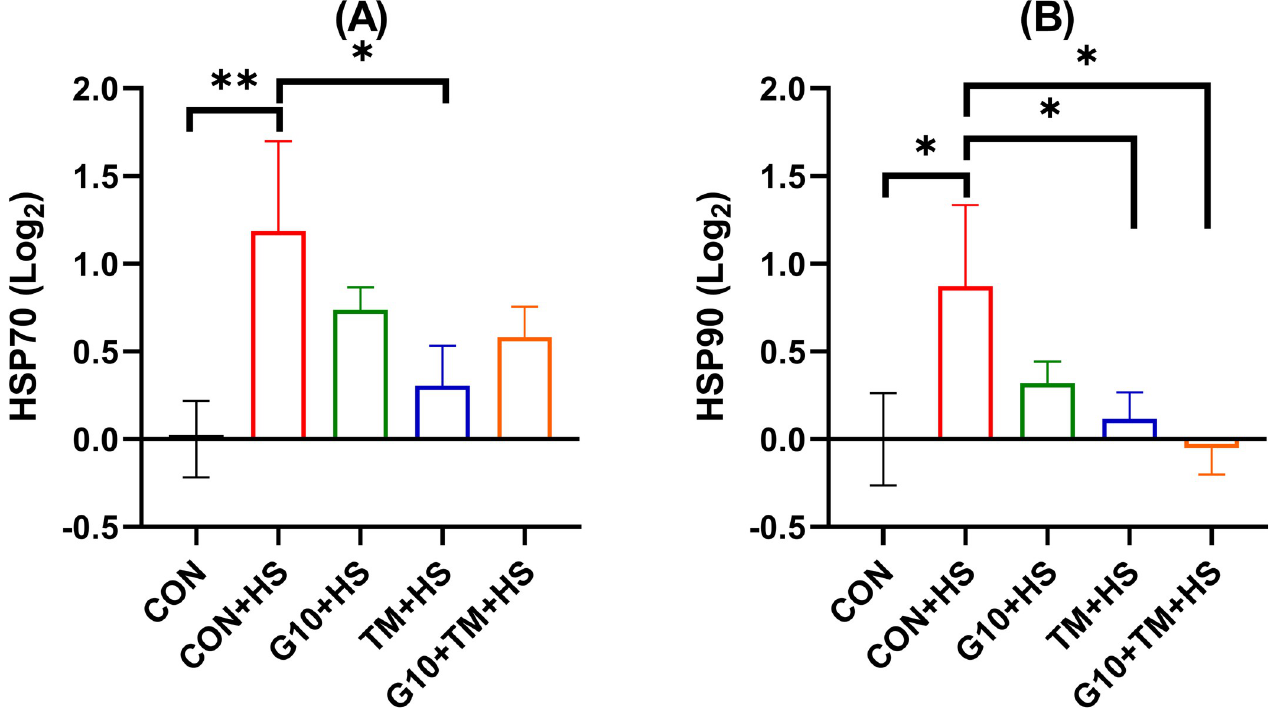
Fig 4. Effects of in ovo feeding of GABA and embryonic thermal manipulation on relative mRNA expression of hepatic HSP70 (A), and HSP90 (B) in broiler chickens exposed to cyclic HS. The treatments are described as follows: CON, chicks hatched from control eggs without in ovo injection and incubated at standard temperature; CON+HS, chicks hatched from control eggs without in ovo injection, incubated at standard temperature but exposed to HS; G10+HS, chicks hatched from eggs injected at 17.5 days of incubation with 0.6mL of 10% GABA dissolved in distilled water and exposed to HS; TM+HS, chicks hatched from thermally manipulated eggs exposed to 39.6˚C for 6 h daily from ED 10 to 18 and exposed to HS; G10+TM+HS, chicks hatched from eggs that received both previous treatments during incubation and exposed to HS. Data show mean ± SEM (n = 5). Results of the contrast analysis are indicated in the graph. Abbreviations: HSP70, heat-shock protein 70; HSP90, heat shock protein